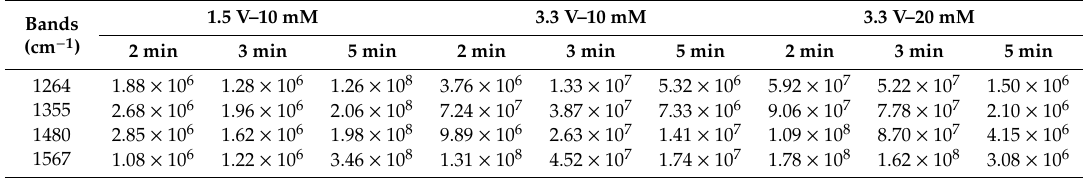
Enhancement factors obtained for four Raman bands of pyridine placed on the SiO 2 –HA–Ag